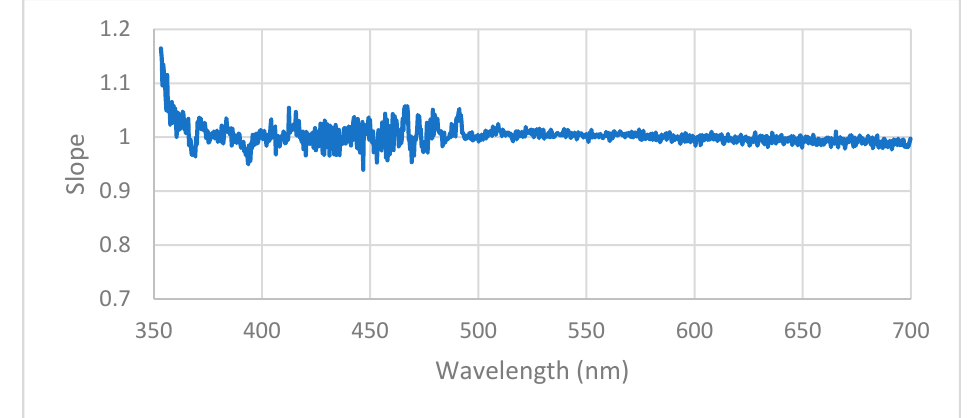
Figure 5. The slope of linear regressions for each pixel computed using three data points corresponding to platform- vs. OceanView-controlled measurement during each of the three filter conditions.